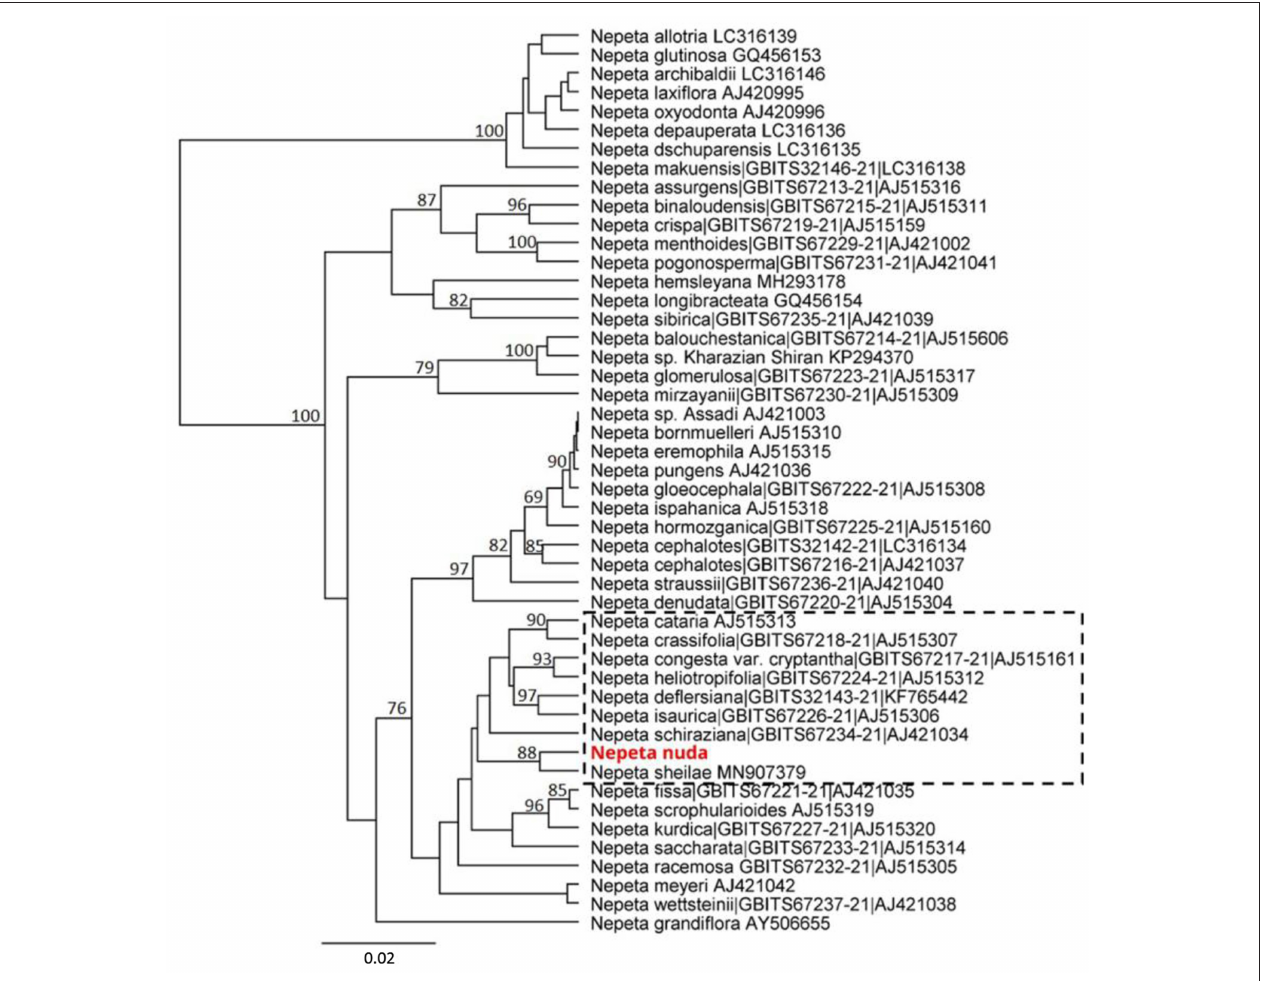
FIGURE 1 | Phylogenetic position of N. nuda compared to accessions from BOLD and NCBI GenBank based on nuclear DNA barcoding marker ITS. The tree was constructed using the UPGMA method and Tamura–Nei model. The percentage of replicate trees in which the associated taxa clustered together in the bootstrap test (500 replicates) are shown next to the branches. Bootstrap values below 75% are not shown. The analyzed N. nuda sequence is depicted in red bold. Accessions from databases are shown with their respective numbers in BOLD and/or NCBI databases. The branch of accessions close to N. nuda is depicted in punctuated